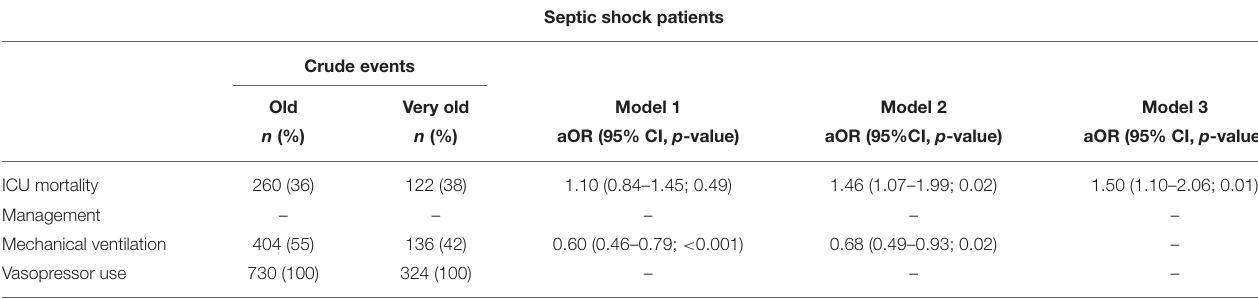
TABLE 4 | Association of old vs. very old septic shock patients with mortality and management strategies in three multi-level logistic regression models.